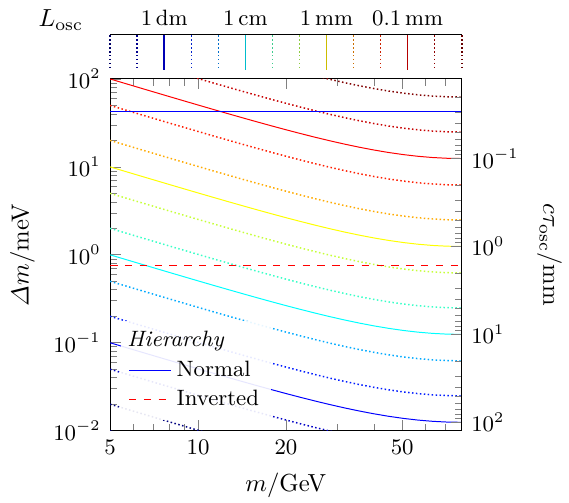
Figure 6 . Oscillation period L osc as a function of the heavy neutrino mass m and the mass splitting ∆ m . The Lorentz factor is estimated using W bosons at rest ( 3 . 14 ). The horizontal lines correspond to the mass splitting appearing in the two minimal linear seesaw BMs given in table 1